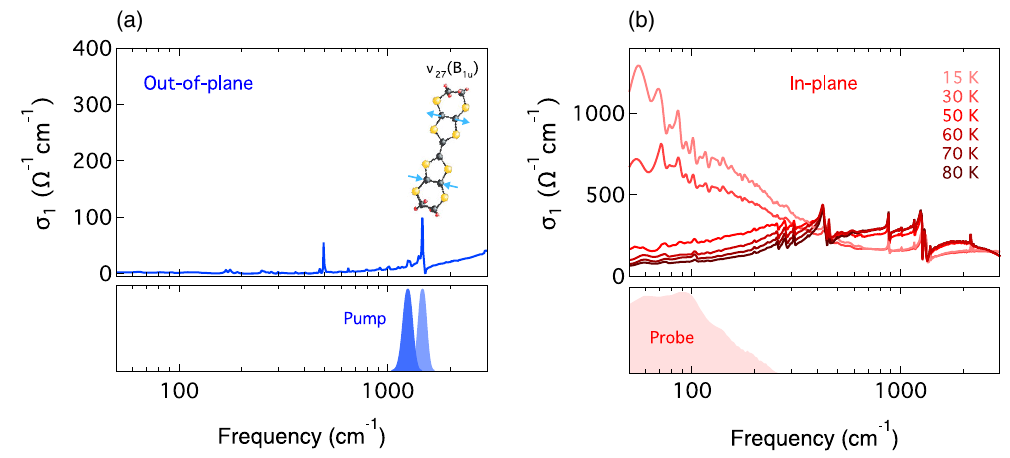
FIG. 2. (a) Upper panel: Out-of-plane equilibrium optical conductivity of κ - ð ET Þ 2 Cu ½ N ð CN Þ 2 (cid:3) Br measured at T ¼ 15 K [14]. Lower panel: Midinfrared pump spectra tuned close to resonance with the ν 27 molecular vibration. The eigenvectors corresponding to this mode are displayed in the upper panel [17]. (b) Upper panel: In-plane equilibrium optical conductivity measured at different temperatures between 15 K and 80 K. Lower panel: Frequency spectrum of the THz probe pulses used in our